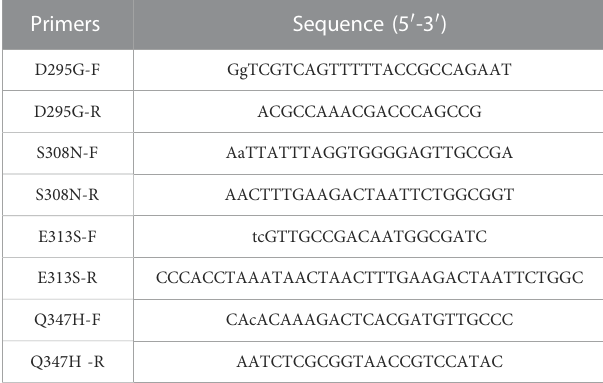
TABLE 2 Primers used in this